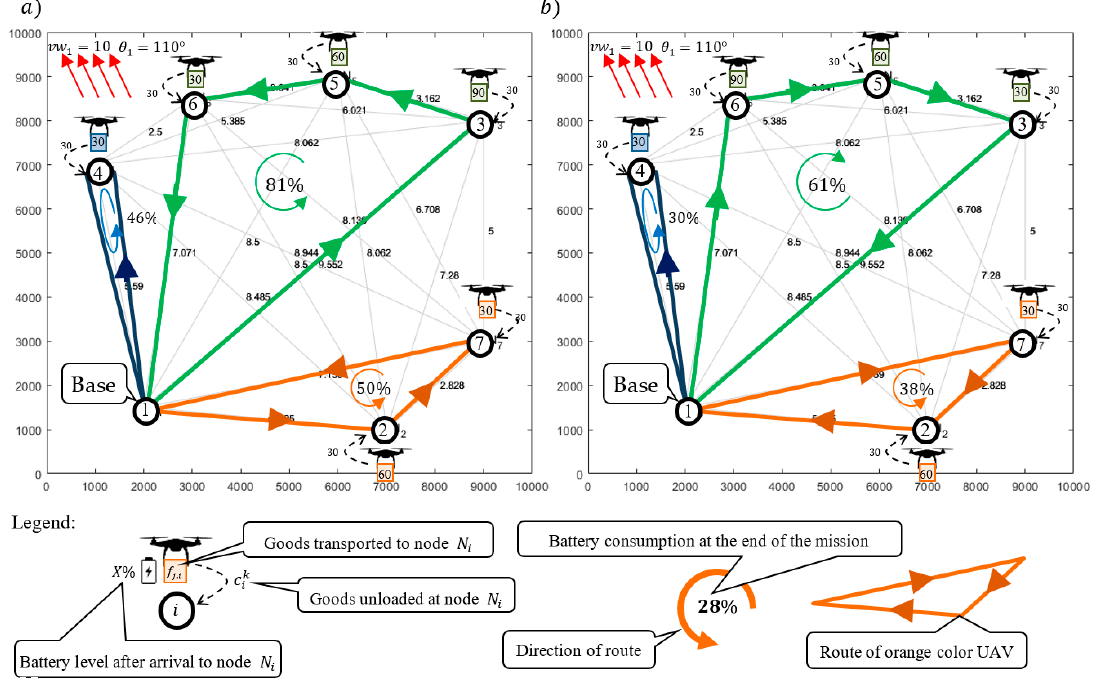
Figure 6. Obtained solution: ( a ) routes for Strategy 1, a constant ground speed; ( b ) routes for Strategy 2, a constant airspeed.